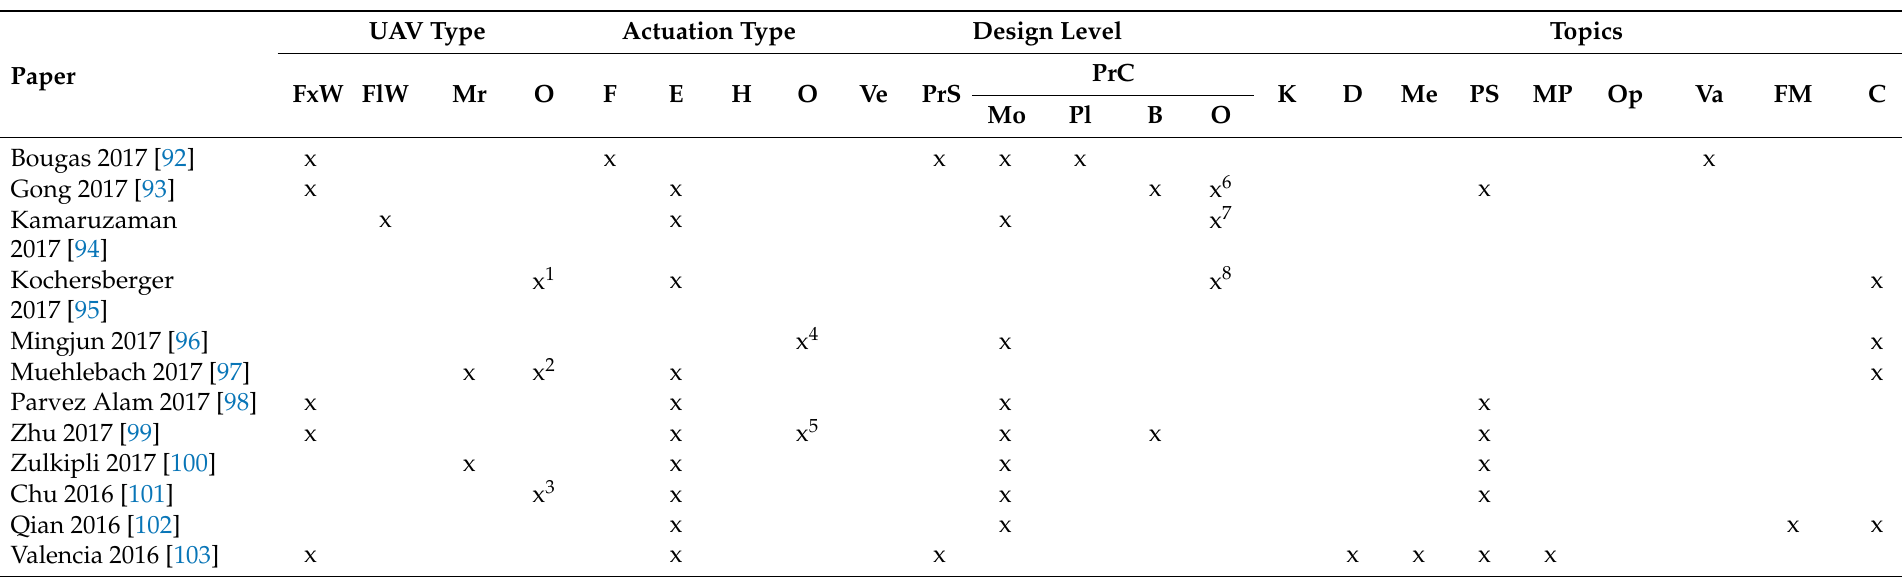
Table 9. Evaluation of the papers categorized in the detailed design category from 2016 to 2017, according to the taxonomy referring to the paper content.